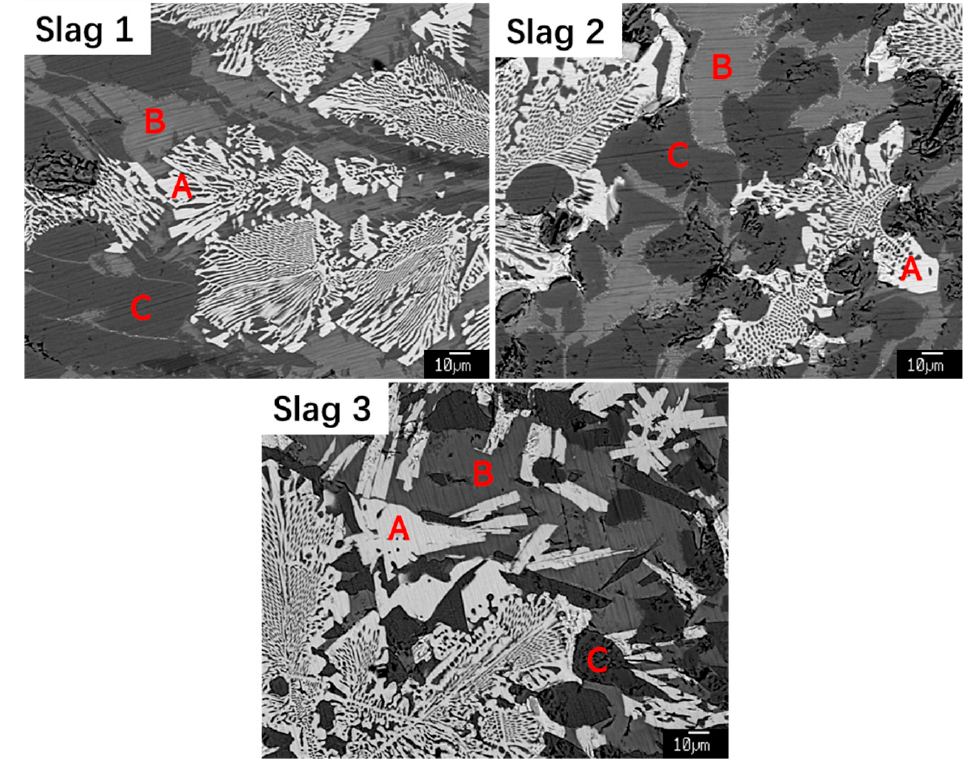
Figure 1. Morphology of dephosphorization slag with different amounts of Fe 2 O 3 content. A,B,C: analysis point. Its composition is described in Table 2. Table 2. Composition of mineral phases in different types of dephosphorization slag (mass%). Mineral